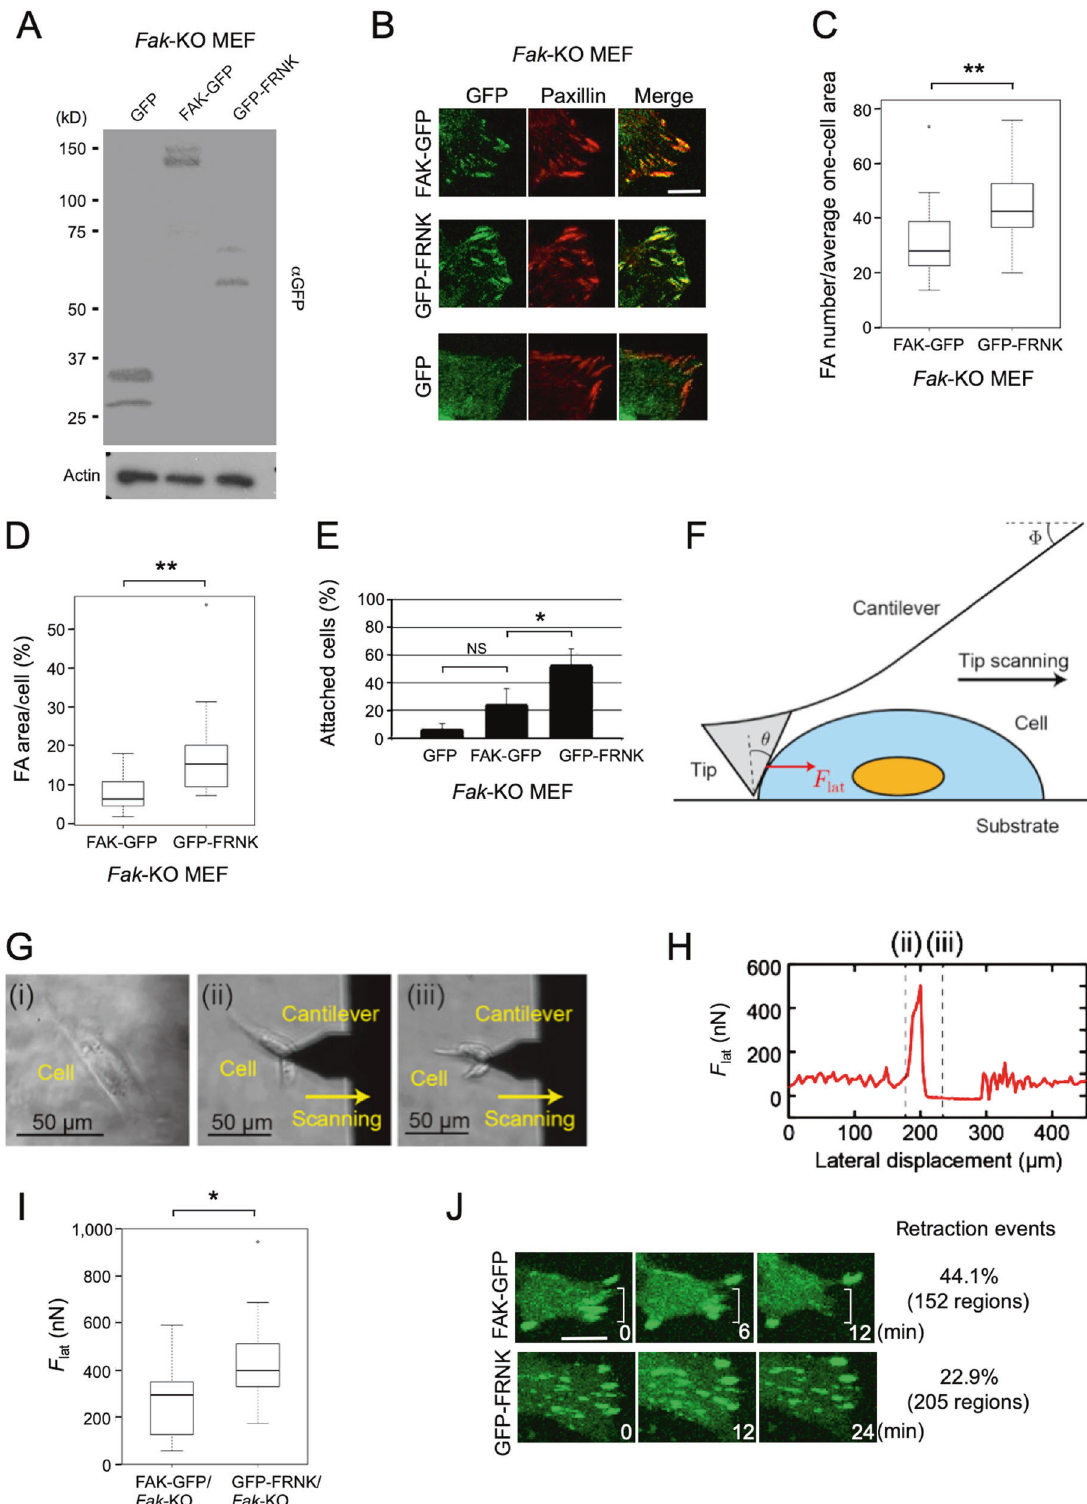
FRNK stabilizes focal adhesions We next sought to characterize FAK-containing and FRNK- containing focal adhesions under normal culture conditions, using Fak -KO MEFs individually expressing either FAK-GFP or GFP-FRNK, as well as their control cells expressing GFP (Fig. 4A). FAK-GFP